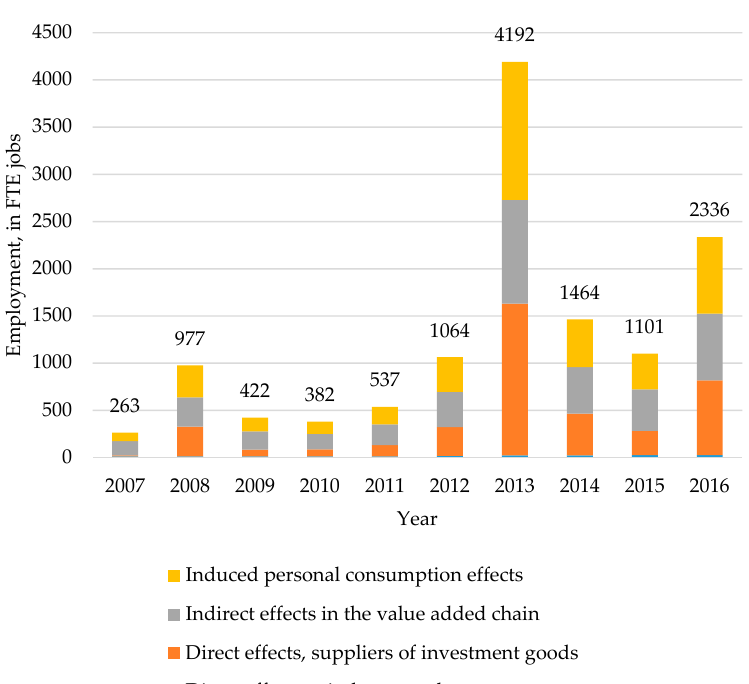
Figure 2. Employment induced by wind power plants deployment and operation in Croatia, number of employees in terms of annual labor input.